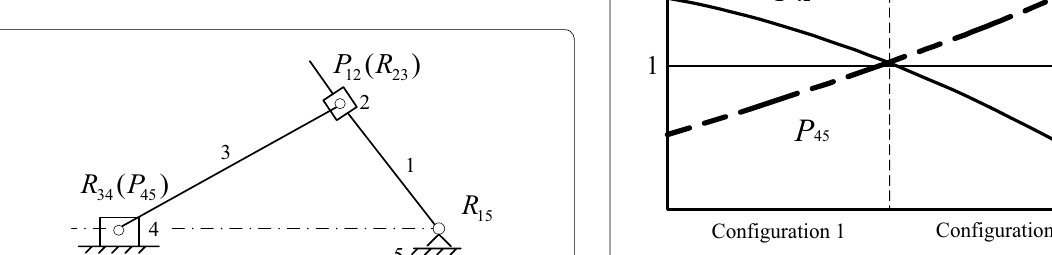
Figure 9 Equivalent resistance gradient sketch of tablet press